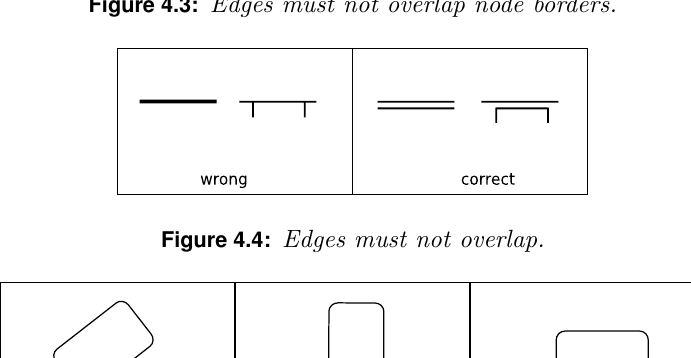
Figure 4.3: Edges must not overlap node borders.